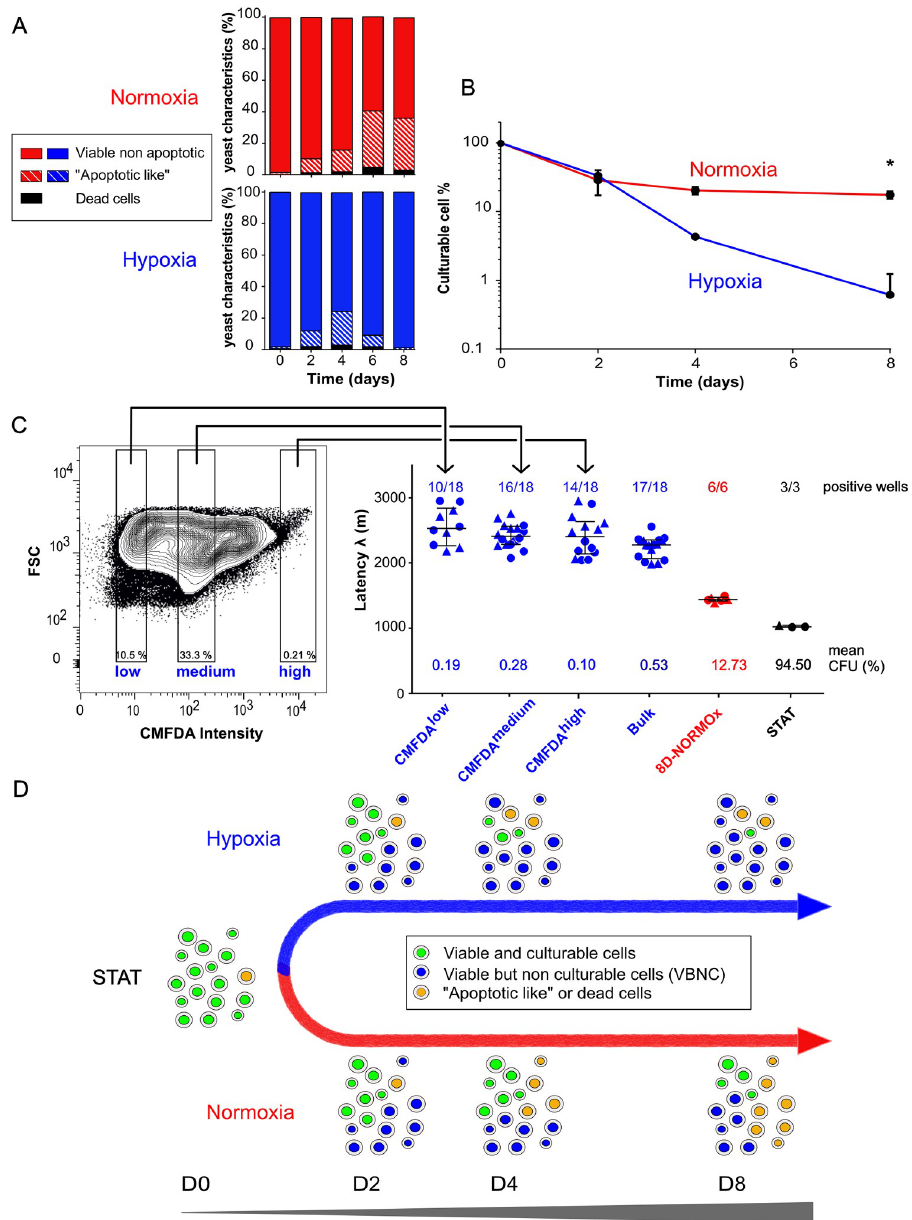
Fig 2. Cryptococcus neoformans incubated for 8 days in hypoxia harbor a homogenous phenotype of viable but non-culturable cell (VBNC). A . Kinetics analysis using multispectral flow cytometry with viability (LIVE/DEAD) and apoptosis (TUNEL) staining showing a homogenous population of viable yeasts after D8 in hypoxia and a heterogeneous population in normoxia with a mixture of viable, apoptotic like and dead yeasts. The experiment was done in triplicate with the median value represented. Viable non-apoptotic cells represented a median proportion of 87.7% [84.2–91.2] at D2, 74.6% [70.5–78.8] at D4, 90.9% [89.7–92.2] at D6, and 98.9% [98.8–99.0] at D8 in hypoxia, 89.4% [88.4–90.5] at D2, 83.5% [83.1–83.9] at D4, 59.6% [59.2–60.0] at D6, 63.6% [62.2–65.0] at D8 in normoxia and 98.7% [98.4–99.0] in STAT. Apoptotic-like cells represented a median proportion 9.9% [6.2–13.8] at D2, 21.4% [17.5– 25.4] at D4, 7.2% [6.5–7.9] at D6, 1.1% [0.9–1.2] at D8 in hypoxia, 8.8% [7.7–10.0] at D2, 13.8% [13.6–14] at D4, 35.8% [34.9–36.7] at D6, 32.9% [31.0–34.9] at D8 in normoxia and 0.8% [0.5–1.6] in STAT cells. The dead cells median proportion was 0.5% [0.4–0.6] in STAT, 1.9% [1.8–2.0] at D2, 2.7% [1.7–3.7] at D4, 1.8% [1.6–2.0] at D6, 0% at D8 in hypoxia1.7% [1.6–1.8] at D2, 2.2% [1.8–2.6] at D4, 5.0% [4.2–5.9] at D6, 3.2% [3.0–3.4] at D8 in normoxia. B